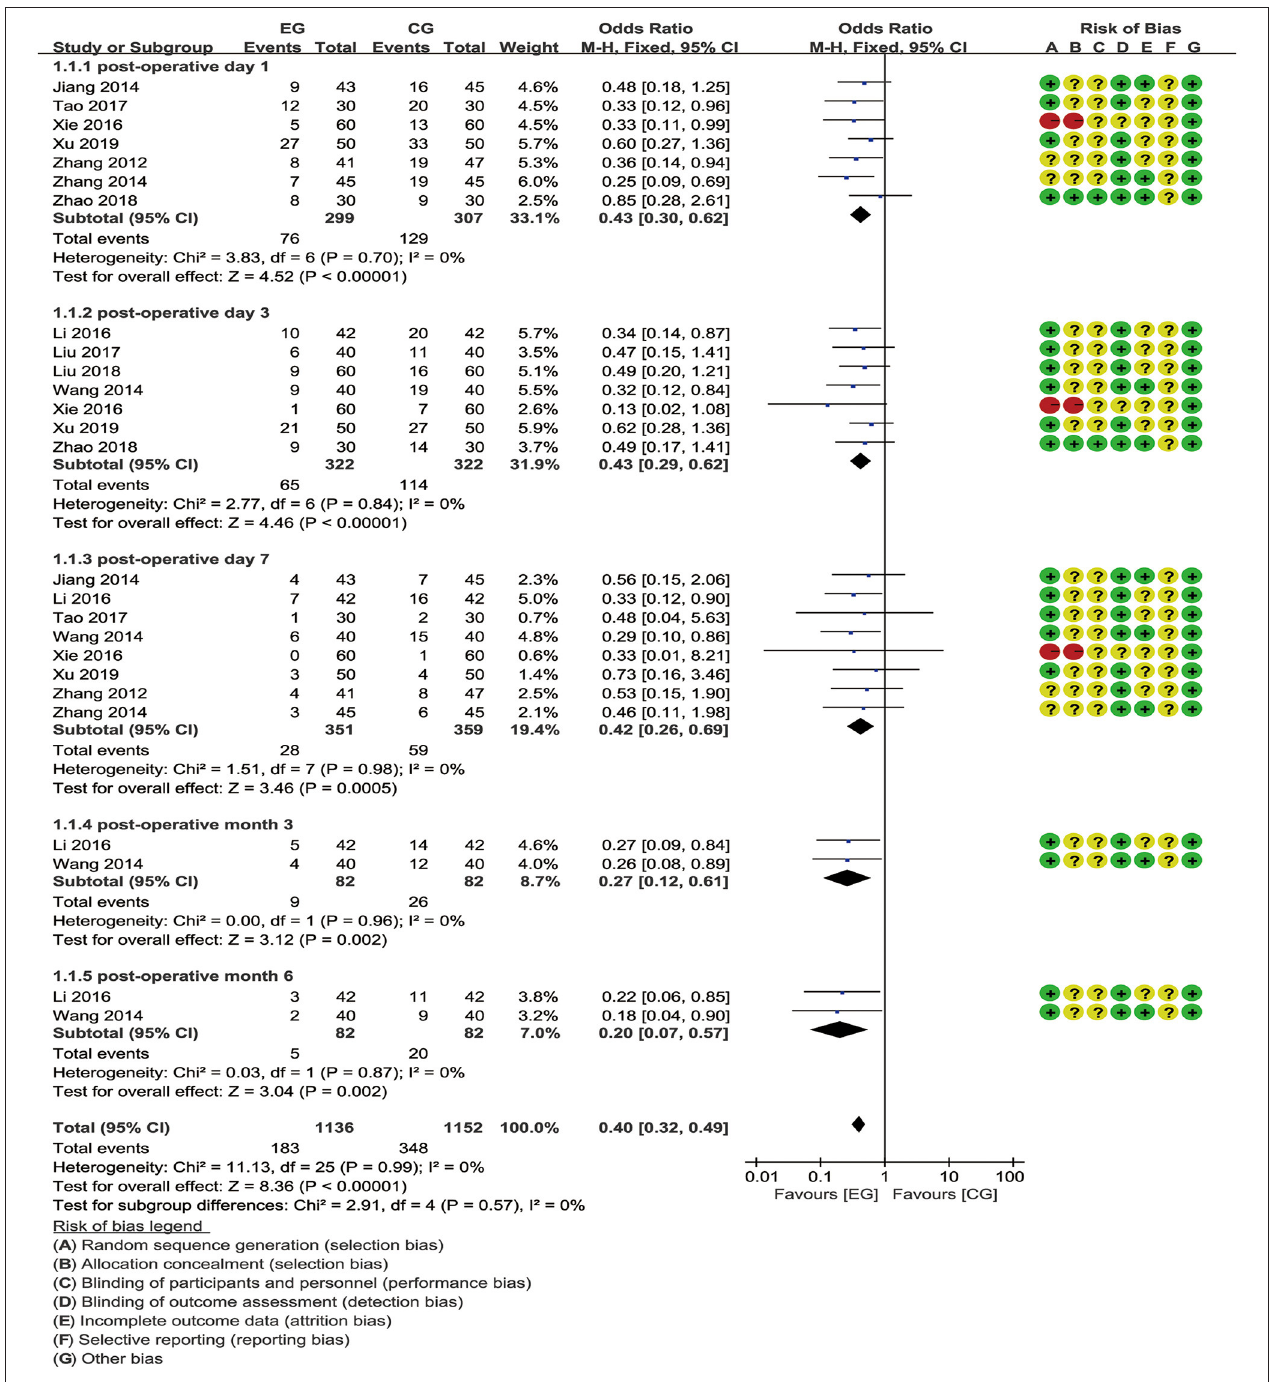
FIGURE 3 | Meta-analysis and forest plot and for the incidence of postoperative cognitive dysfunction (POCD) at different periods.